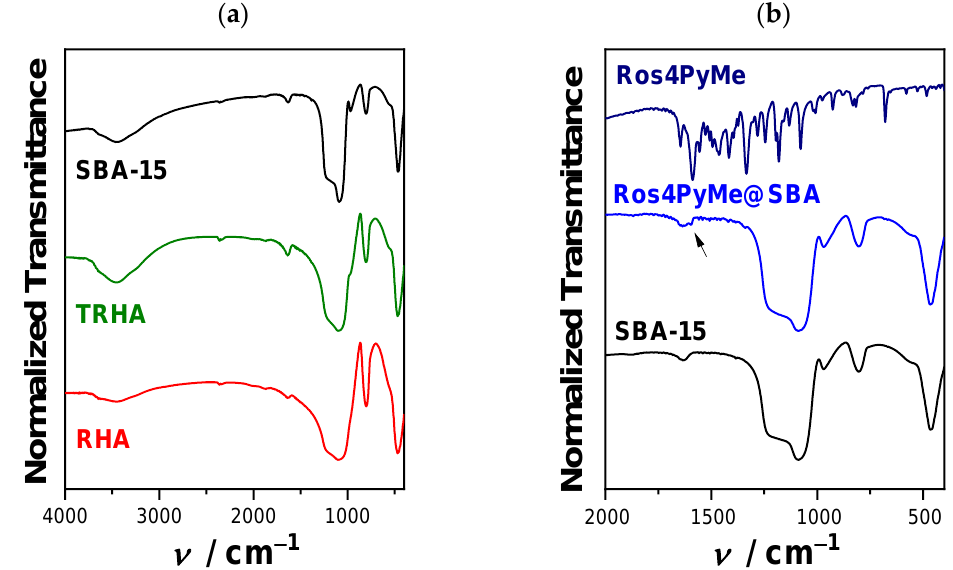
Figure 4. FTIR spectra of: ( a ) RHA, TRHA, and SBA-15 in the range 4000–400 cm − 1 and ( b ) SBA-15, Ros4PyMe@SBA, and Ros4PyMe between 2000 and 400 cm − 1 .